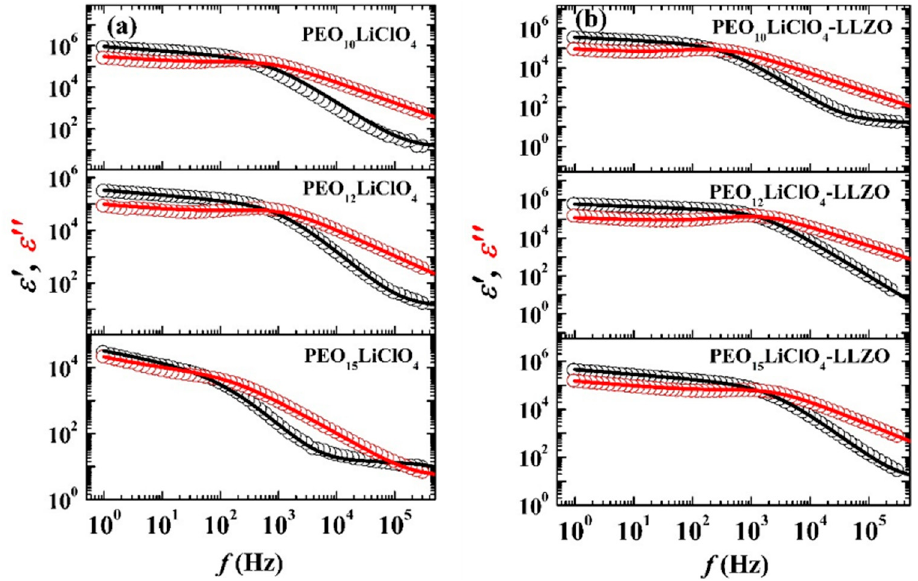
Figure 3. Frequency dependence of ε (cid:48) and ε (cid:48)(cid:48) of ( a ) PEO n LiClO 4 and ( b ) PEO n LiClO 4 -LLZO. The open circles and solid lines represent the experimental data and the fitted data.